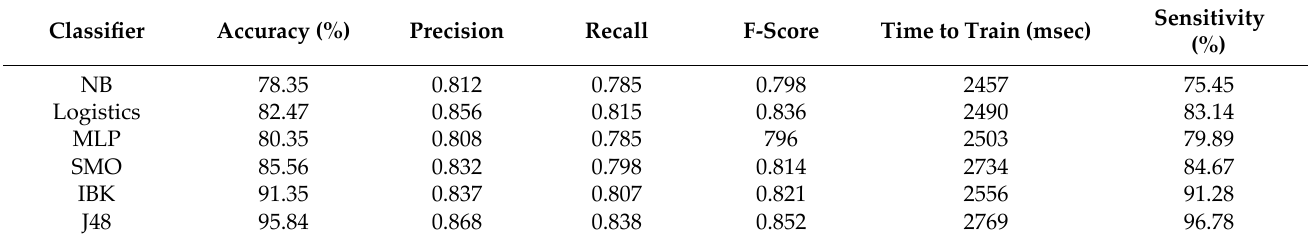
Table 16. Classifiers Training vs. Testing Performance